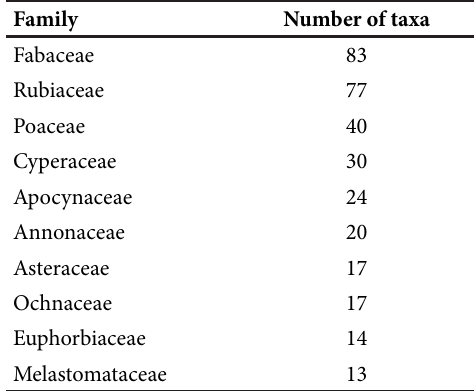
Table 3. Top nine genera represented in the checklist, with number of